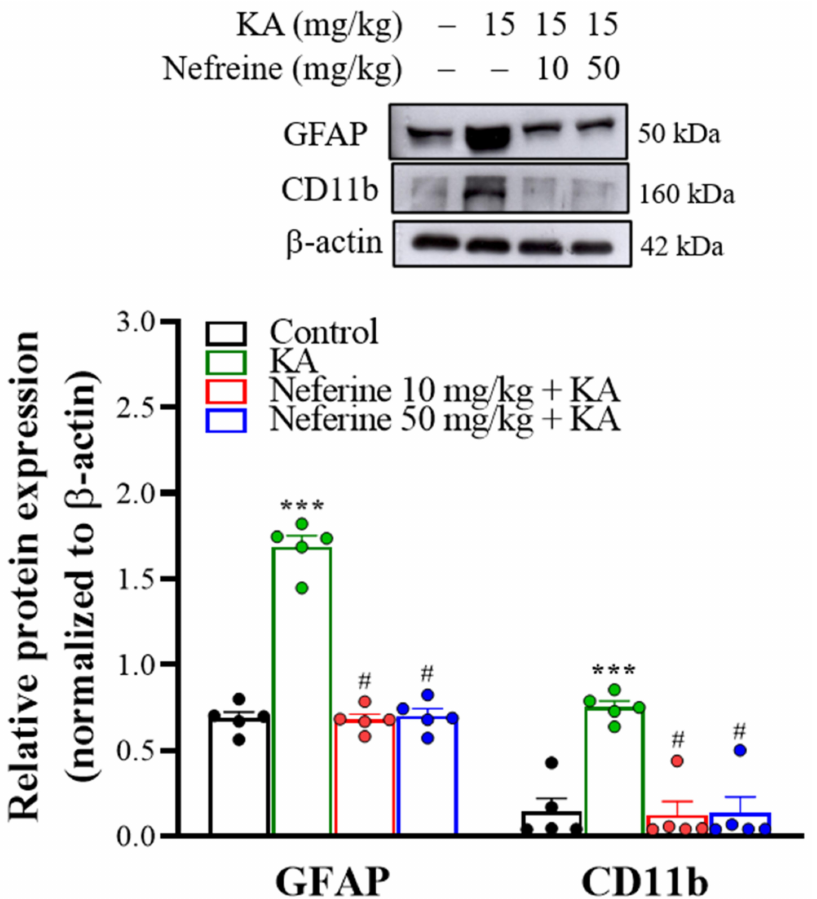
Figure 4. Western blot analyses of GFAP and CD11b proteins in rat hippocampal tissue. Representa- tive images in the different groups and densitometric values for GFAP and CD11b were normalized to β -actin levels ( n = 5 rats/group). Statistical results of the immunoblot analysis show that neferine reduced the band intensity of GFAP and CD11b (one-way ANOVA). *** p < 0.05 vs. control group. # p < 0.05 vs. KA-treated